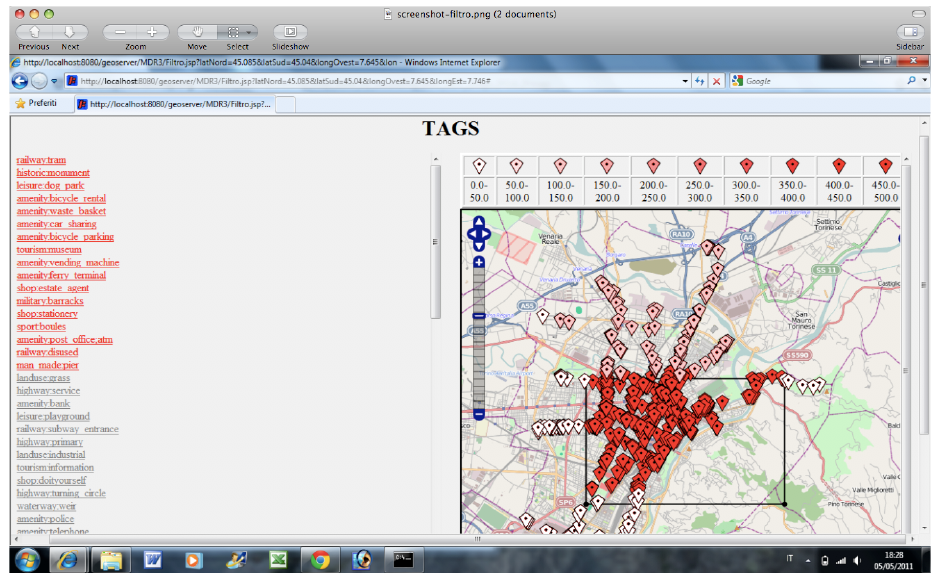
Figure 15. Filtered annotations (on bus-stops) are listed in red and appear in the map with a color that depends on their